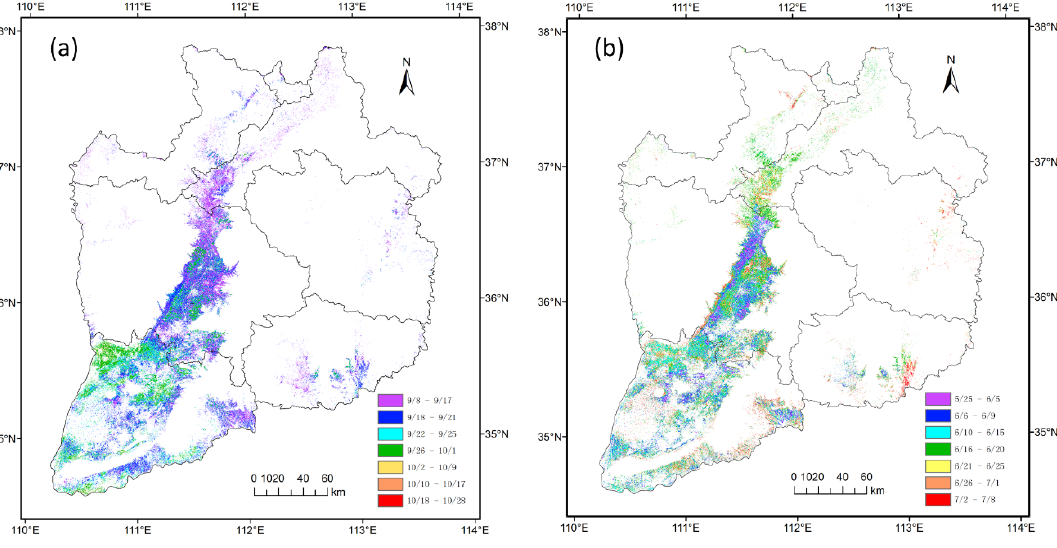
Table 4. Error matrix for SVM classification. TIN, time-integrated.